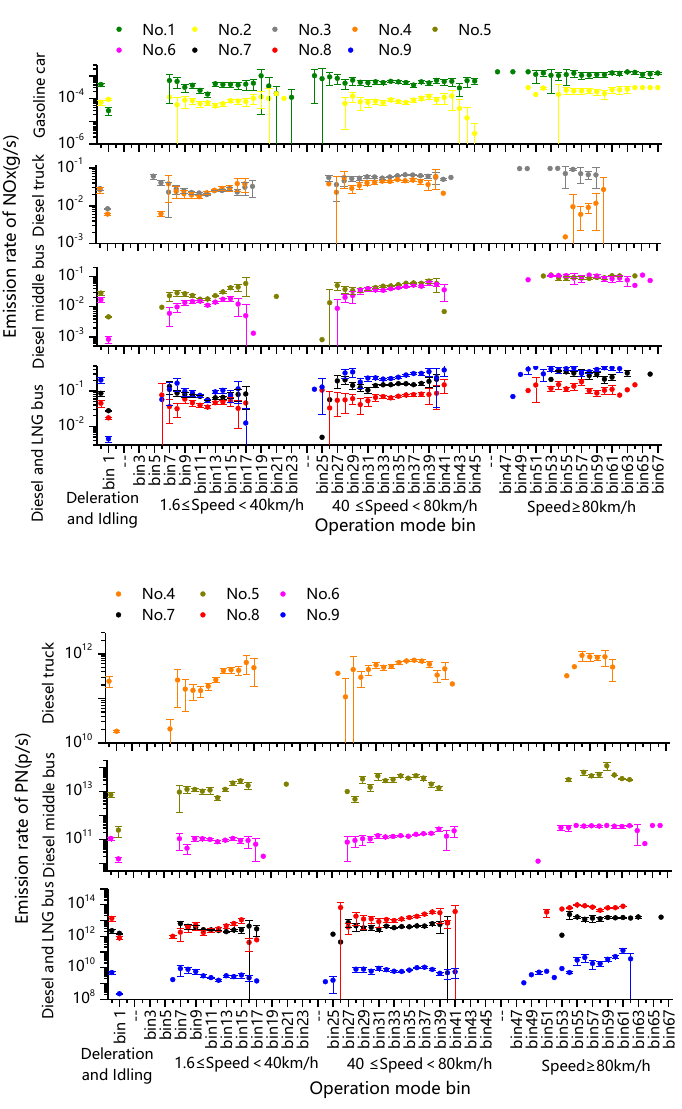
Figure A1. The emission rates of pollutants for each test vehicle according to the operation mode bins.